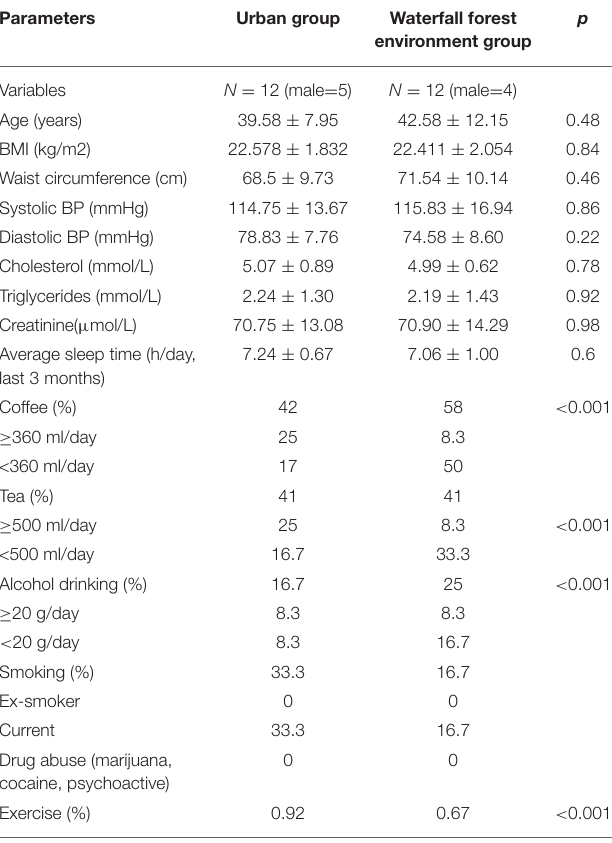
TABLE 1 | Characteristics of patients with chronic fatigue at study start.